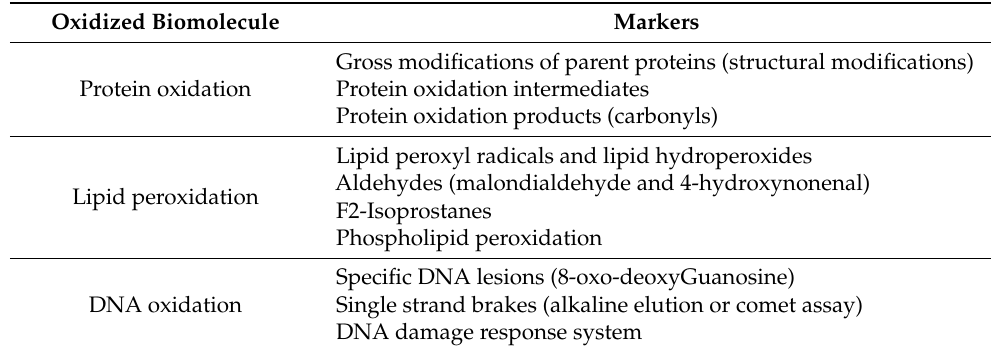
Table 2. Markers for oxidative damage detection and quantification.